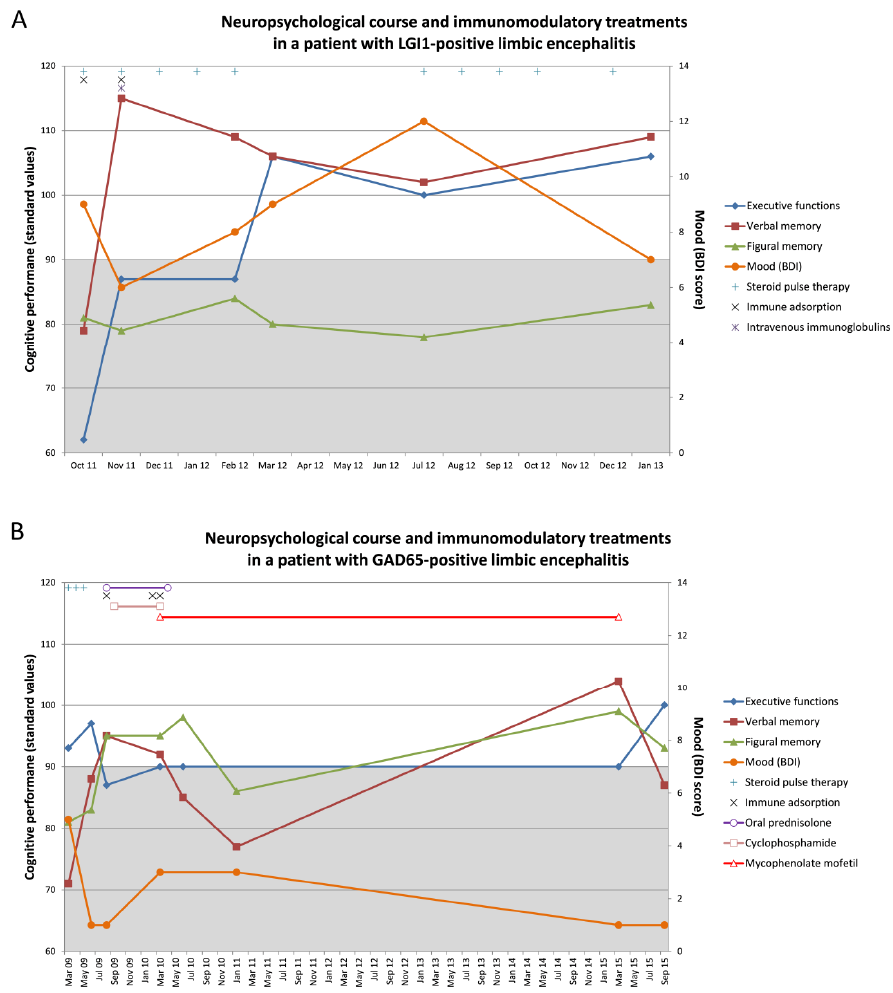
Figure 1. Exemplary cases demonstrating the cognitive monitoring of patients with limbic encephalitis (LE). The figures show the neuropsychological course and immunomodulatory treatments in ( A ) a patient with LGI1-positive LE and ( B ) a patient with GAD65-positive LE. The left y -axis refers to the cognitive performances which are presented in standard values. The below average range (i.e., a standard values below 90) is highlighted in grey. The right y -axis refers to the Beck Depression Inventory (BDI) score. A BDI score >10 would indicate depressed mood.